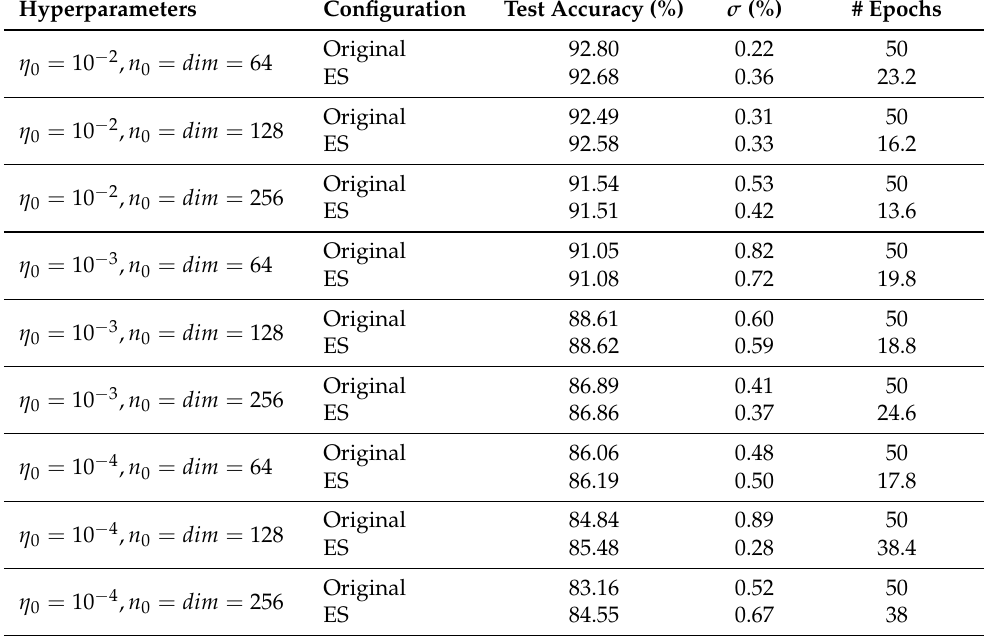
Table 3. Hyperparameters analysis on MedMNIST2D OrganSMNIST dataset in a maximum of 50 epochs. σ is the standard deviation and each result is the mean of five